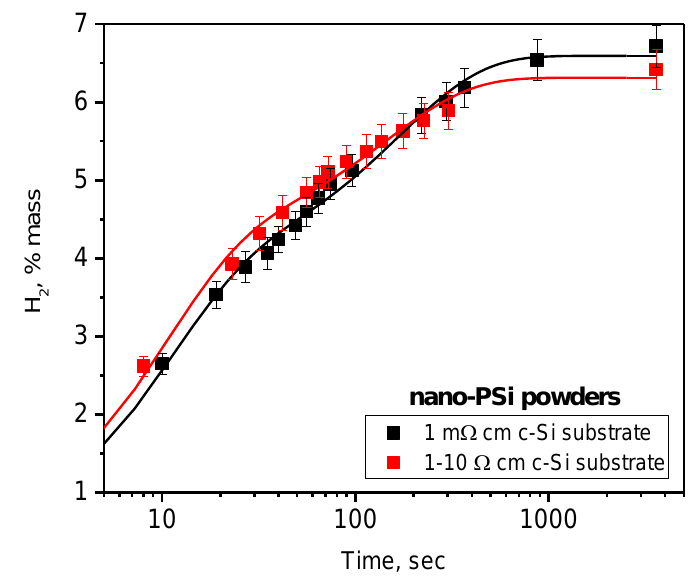
Figure 8. Kinetics of hydrogen generation depending on resistivity of silicon substrates used for fabrication of nano-PSi powder. The oxidation reaction occurs in solutions of water:ethanol = 3:2 containing NaOH in concentration of 0.21 M/L. Discrete points correspond to experimentally measured values, while solid lines are the fitting functions given in Supplementary Materials.